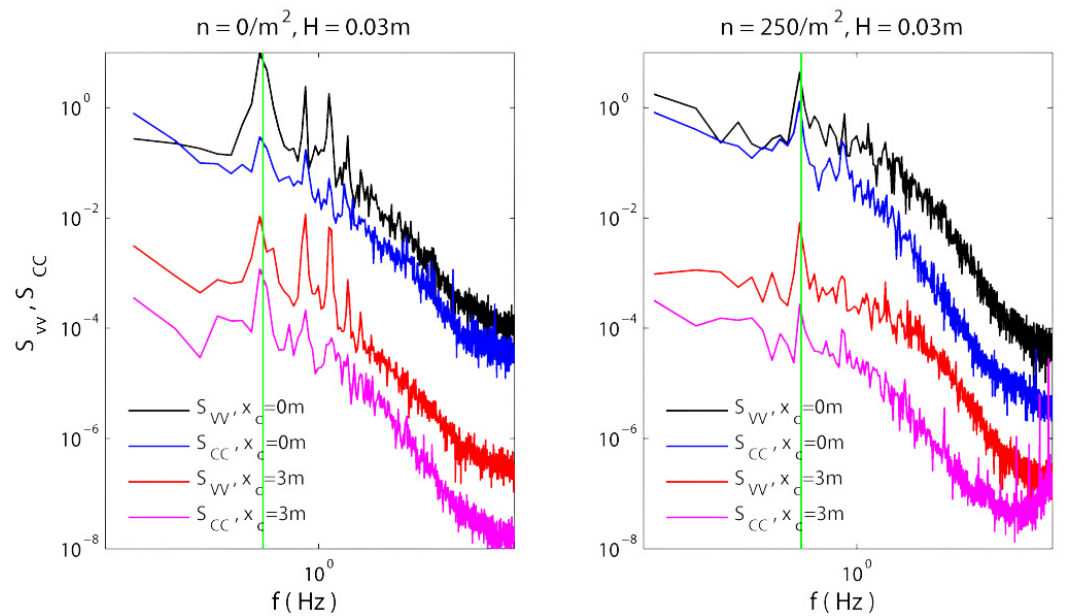
Figure 15. Frequency spectra of transverse velocity and concentration for the cases n = 0m − 2 (left) and n = 250m − 2 (right), at longitu- dinal locations x c = 0 and x c = 3m. Vertical green line shows the considered wave period T = 2 . 5s. Actual amplitudes altered to improve